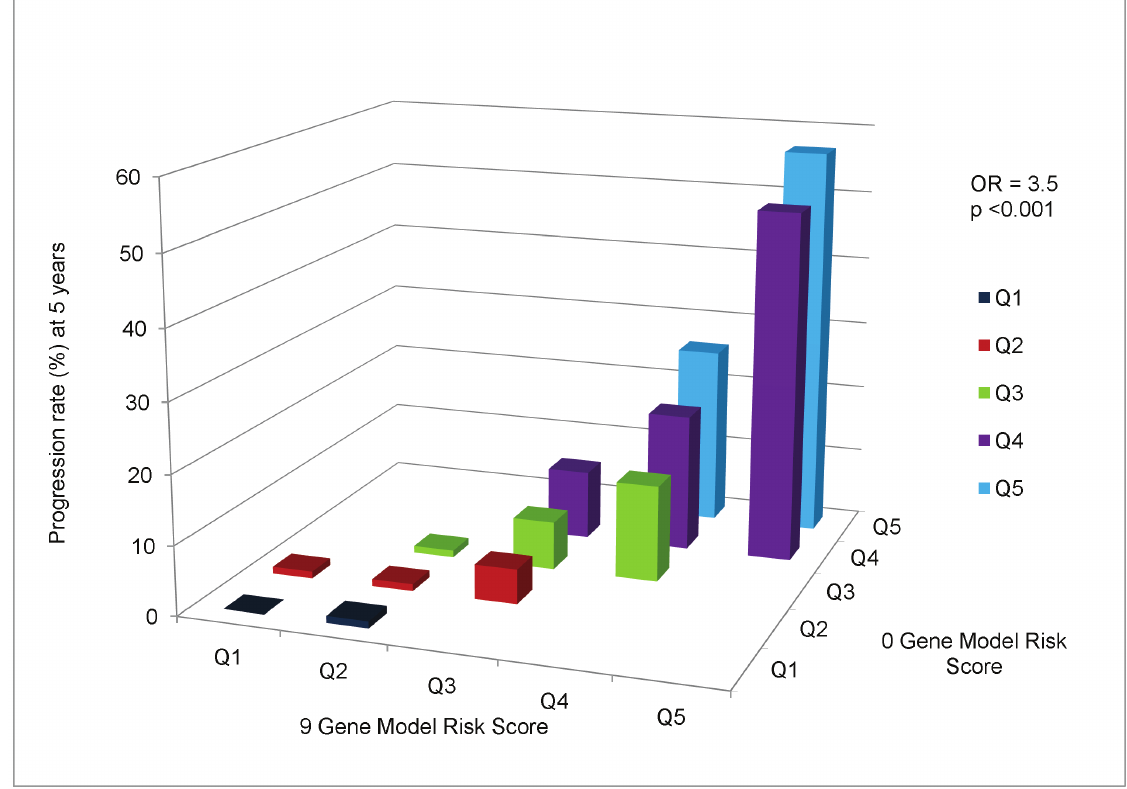
Figure 2. Cross-Classification of Progression Rates to Advanced AMD: 9 Gene Model vs 0 Gene Model. Cross-classification of subjects by risk score quintile for 9 and 0 gene models, with estimated progression rates for each combination of a 9 gene quintile by 0 gene quintile. OR=odds ratio of progression per one quintile increase in 9 gene model, holding 0 gene model quintile constant.